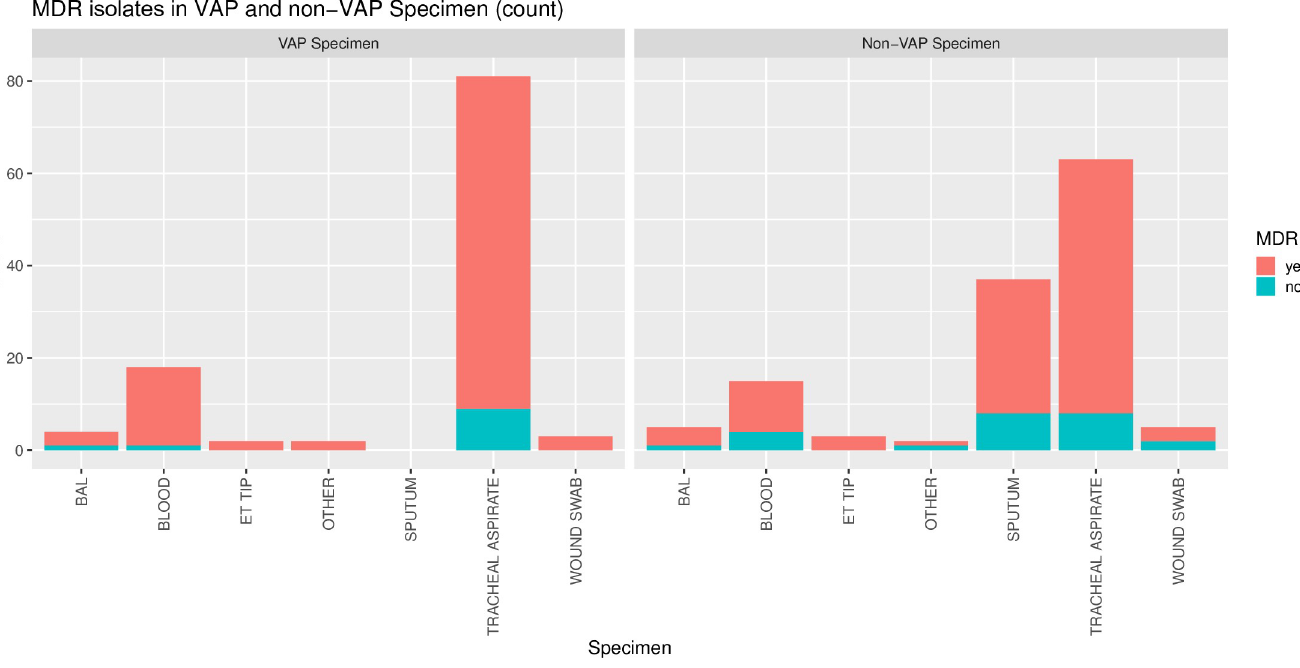
PLOS ONE | https://doi.org/10.1371/journal.pone.0259634 November17,